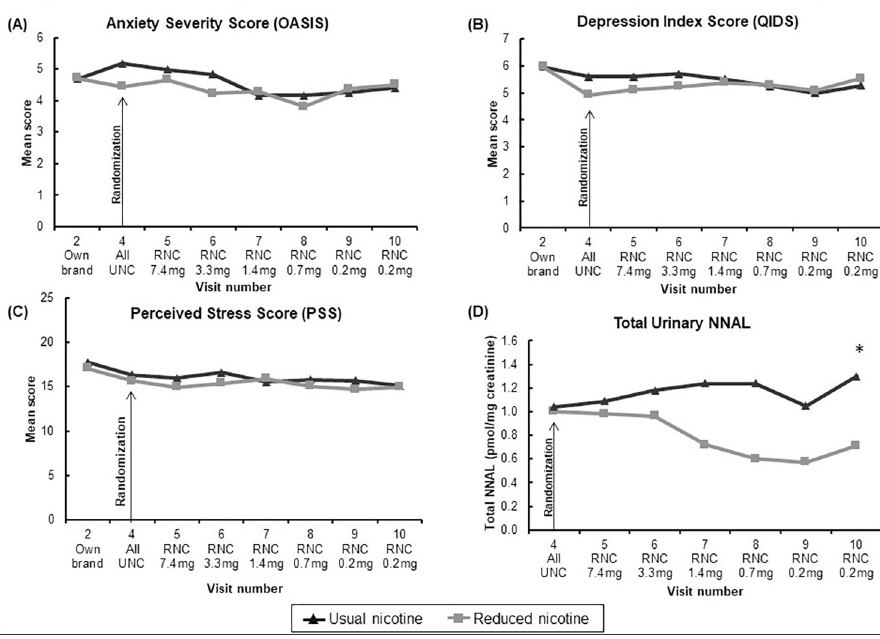
Fig 3. 3A-3D. Changes in OASIS, QIDS, PSS, and NNAL # among completers (n = 143) smoking either Usual Nicotine Content (n = 74) cigarettes or Reduced Nicotine Content (n = 69) cigarettes. � indicates statistically significant between group difference at Visit 10, controlling for Visit 4 baseline. # urine NNAL measured in randomly selected subgroup (n = 26 on RNCs and n = 25 on UNCs, evenly stratified by site and by study group), who provided urine samples at randomization (v4) and at the end of the randomized phase of the trial (v10).